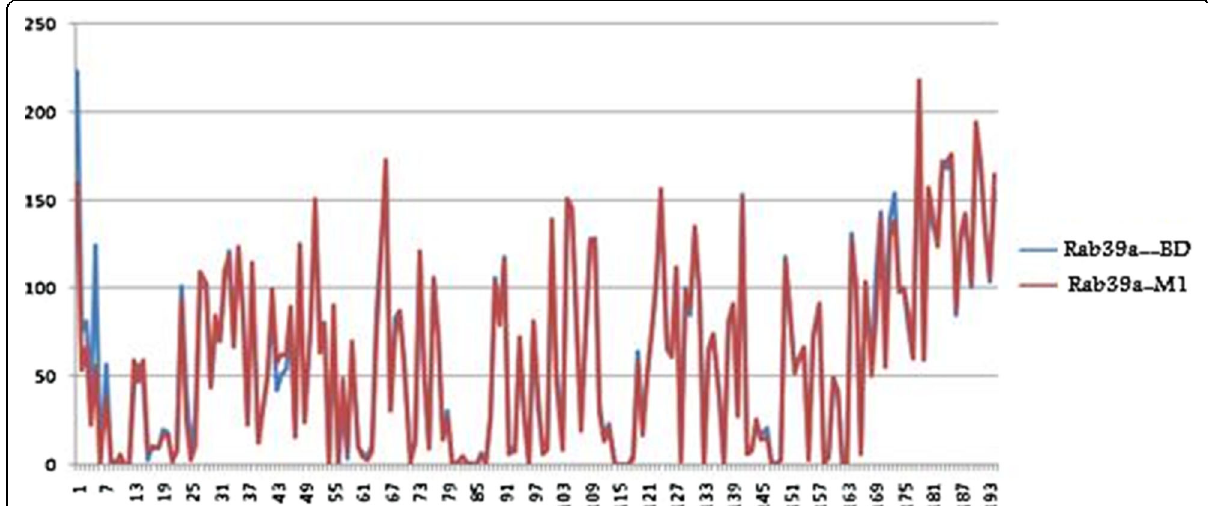
Fig. 12 Solvent accessible surface area of Rab39a and Rab39a/ligand complex: The SASA value [34] of Rab39a before docking (Rab39a-BD) is represented in blue color peak, and the protein-ligand complex (Rab39a-M1) is represented in red color. The residues are shown on the X -axis and the SASA values are shown on the Y -axis